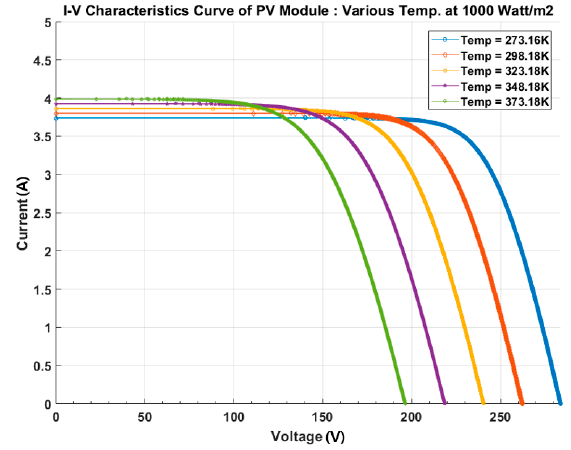
Figure 11. PV Array I-V Curve with various temperatures.